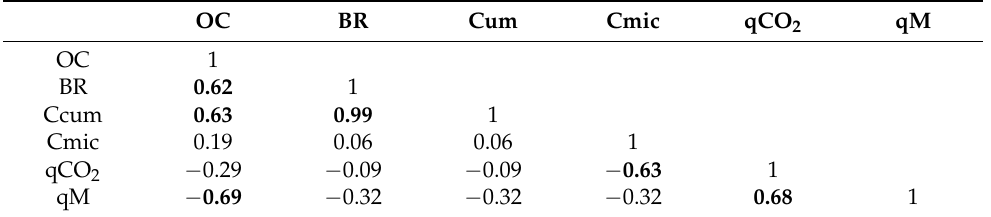
Table 3. Correlation matrix among the indicators used for biological fertility index (BFI) calculation in the three investigated sites. In bold, significant ( p < 0.05) correlations are reported. OC BR